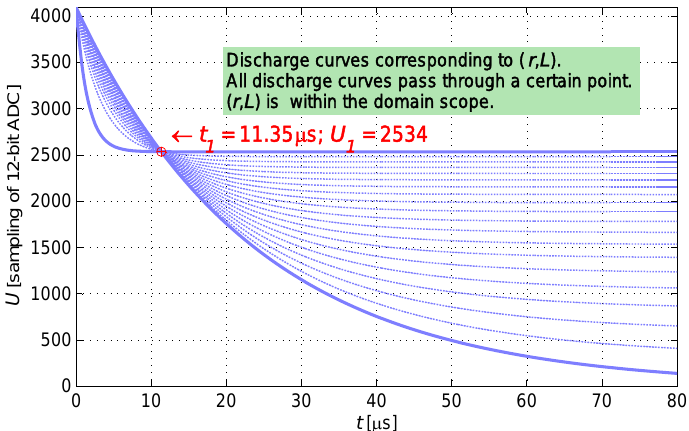
Figure 5. Cluster of curves passing through ( U 1 , t 1 ) .